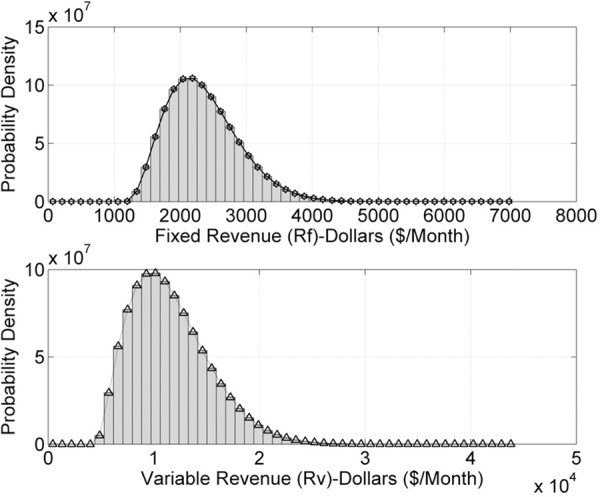
RF(t) and Rv(t) probabilities for n = 109 samples/